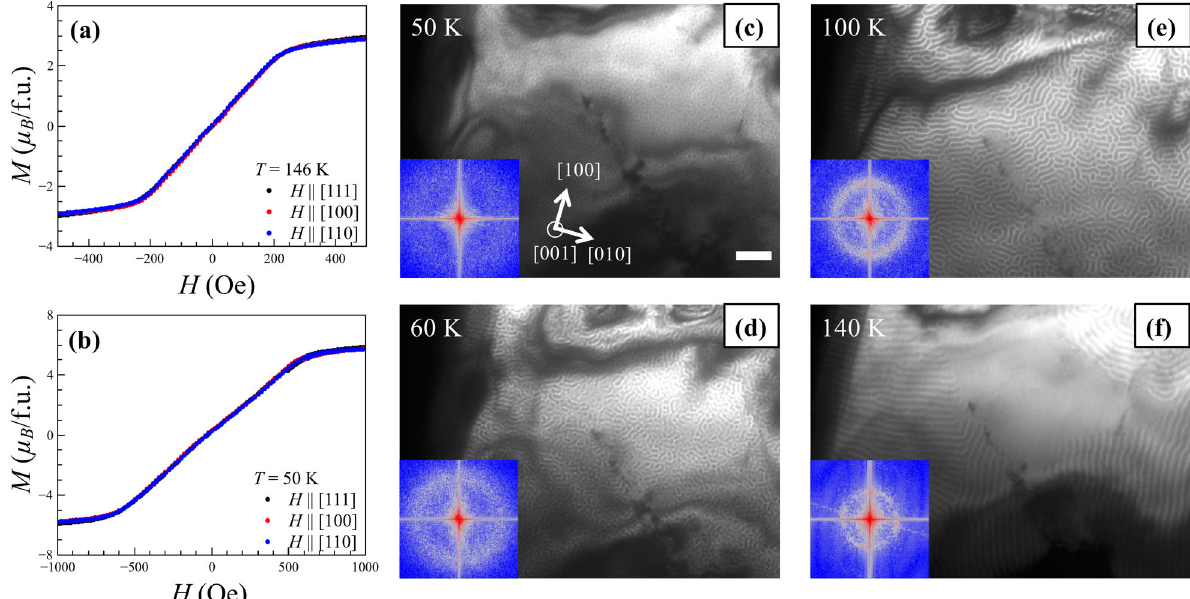
Fig. 4 Magnetization curves and Lorentz microscopy. Magnetization curves of bulk Co 7 Zn 7 Mn 6 measured for principal crystallographic axes at ( a ) 146 K and ( b ) 50 K. Evolution of the magnetic textures in thin plate Co 7 Zn 7 Mn 6 measured on zero- fi eld warming at ( c ) 50 K, d 60 K, e 100 K and ( f ) 140 K. The white scale bar corresponds to 500 nm. The insets show corresponding fast Fourier transform patterns. Details of the LTEM measurement protocol are given in “ Methods ”